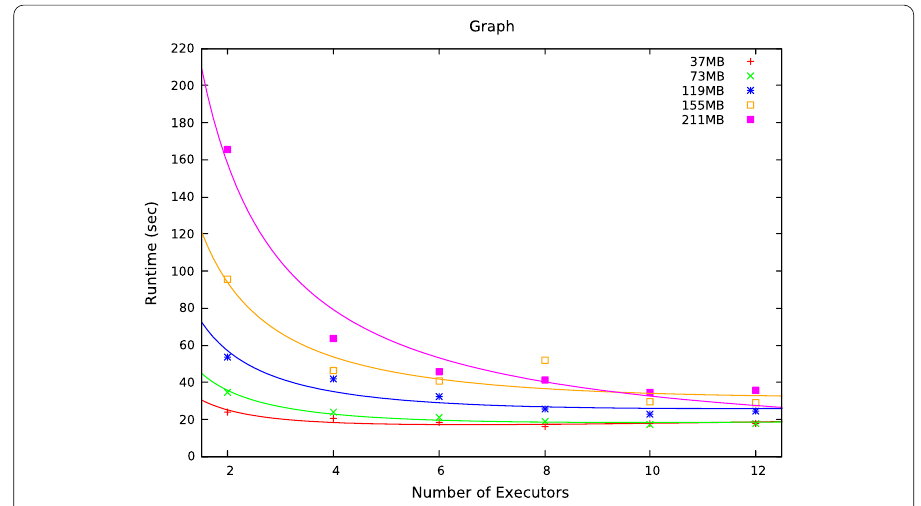
Fig. 15 Fitting the 2D plate model to NWeight (Graph)